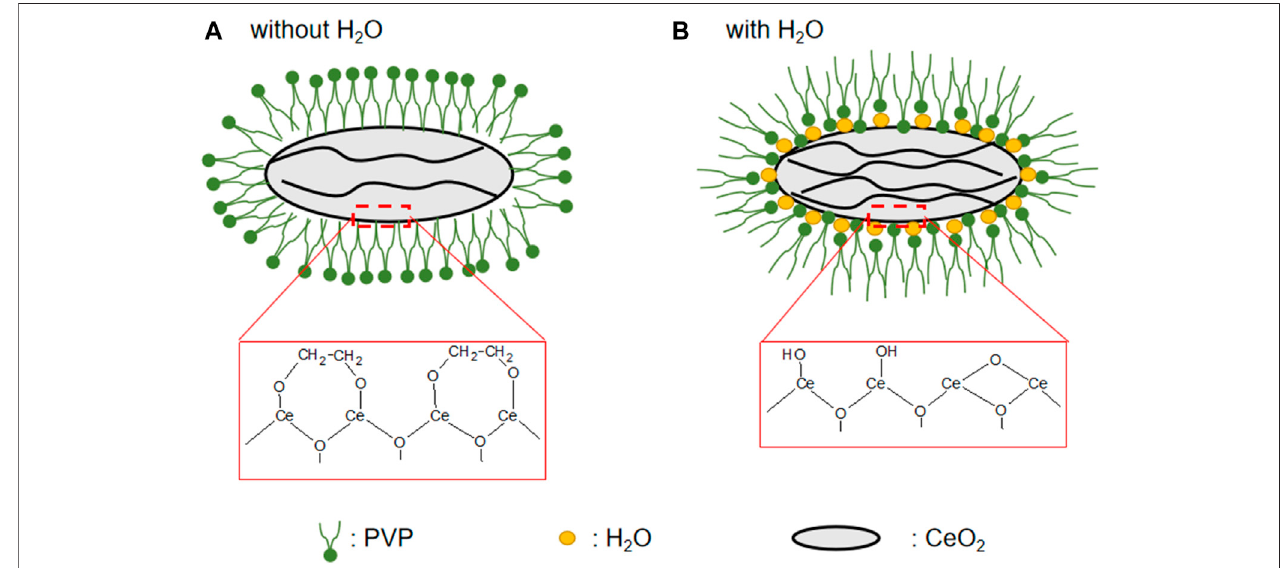
FIGURE 6 | Sketch of the in fl uence of H 2 O on the structure of CeO 2 . (A) Without H 2 O. (B) With H 2 O.